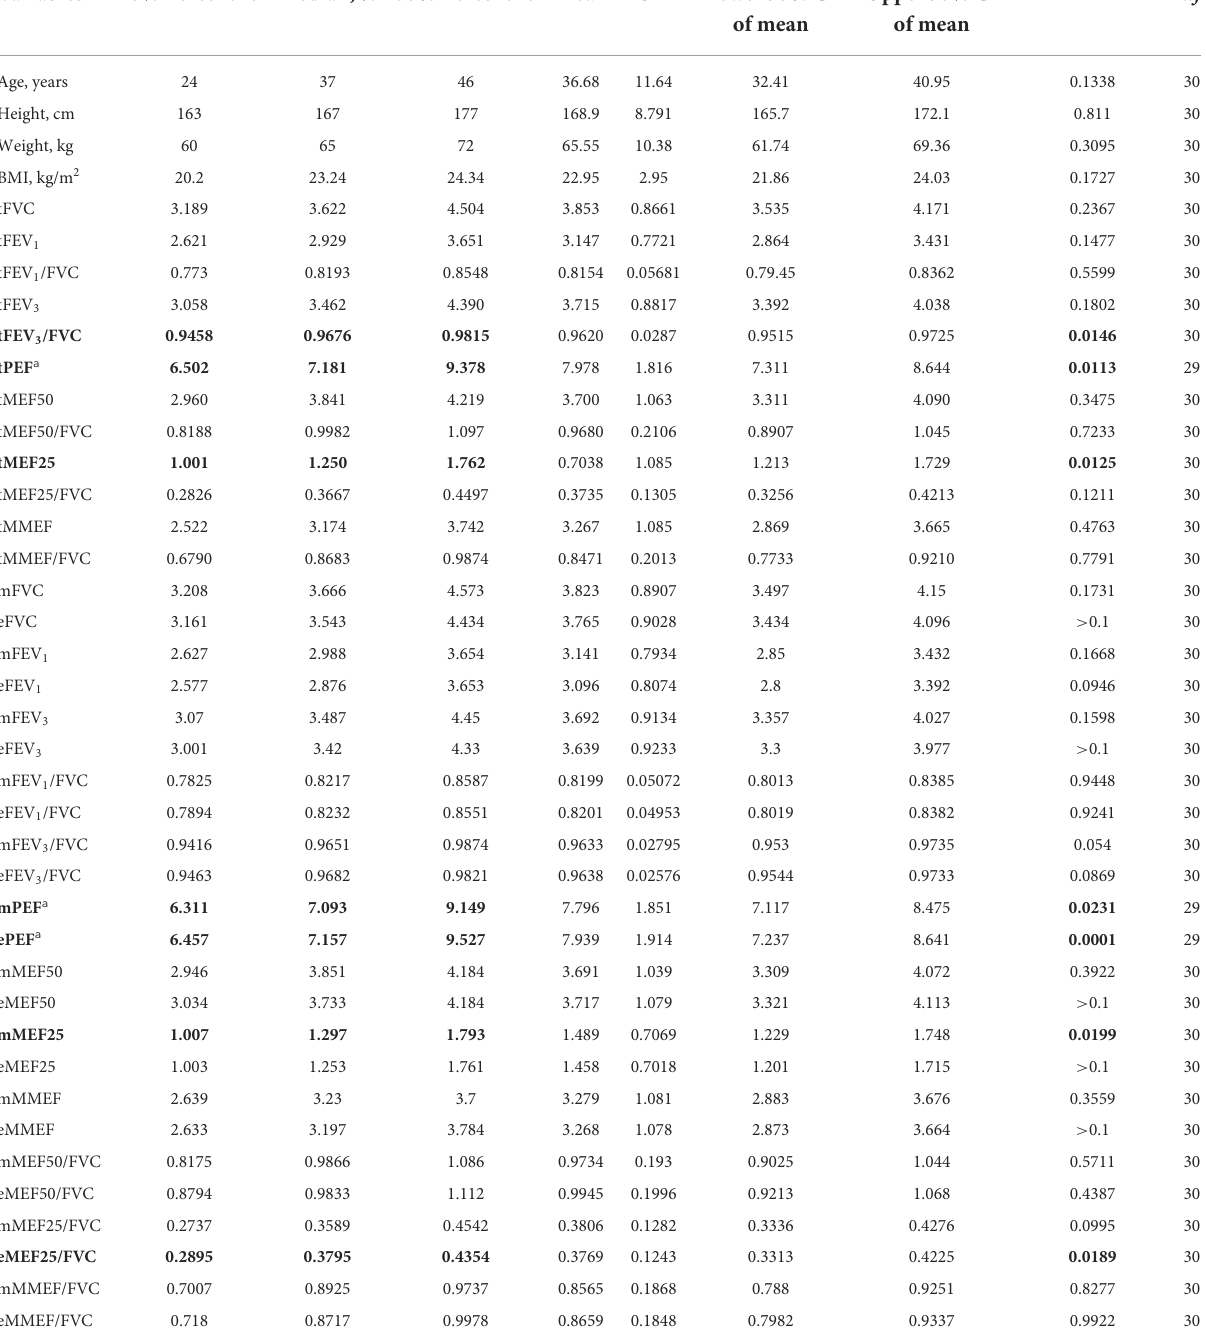
TABLE 1 Demographic data and portable spirometry variable values of non-smoking healthy adults.